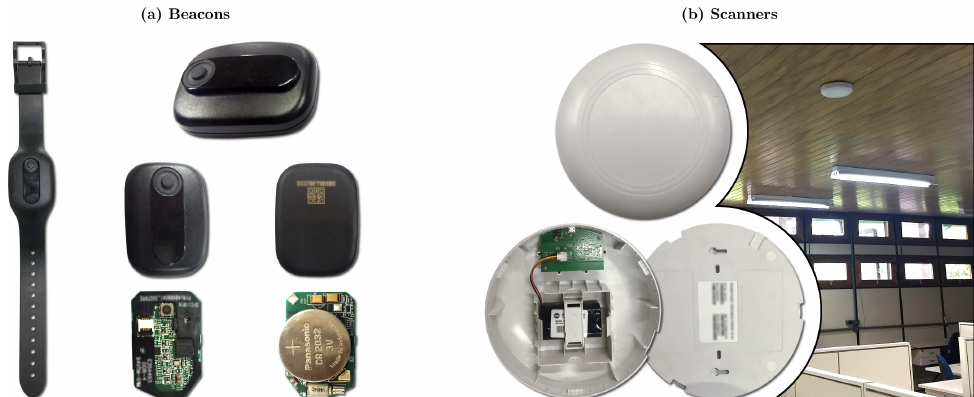
Figure 6. SmartCampus Hardware: ( a ) beacons with Bluetooth communication; one beacon is inside a bracelet, as used by the users; the other beacons are outside the bracelet (front and back), and opened to show hardware (front and back); and ( b ) scanners with Bluetooth and 900 MHz long-range communication (front, opened, back, and installed on the ceiling). The gateway has a similar hardware footprint as of the scanners, and the server is not shown.